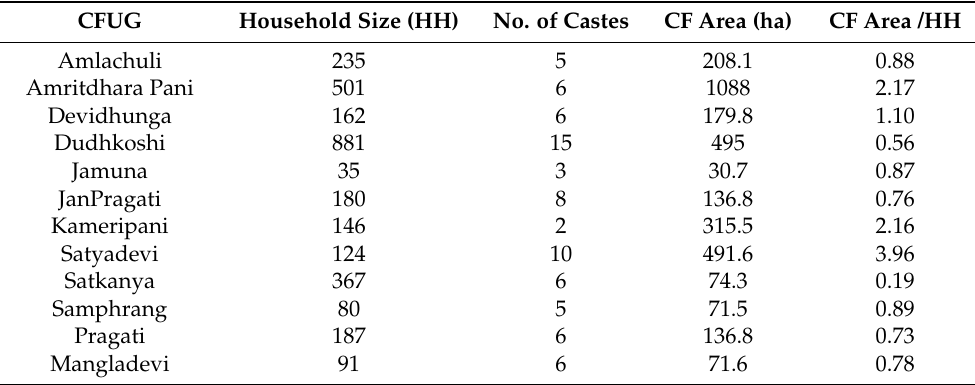
Table 1. Characteristics of the community forest user groups (CFUGs) in the studied community forests